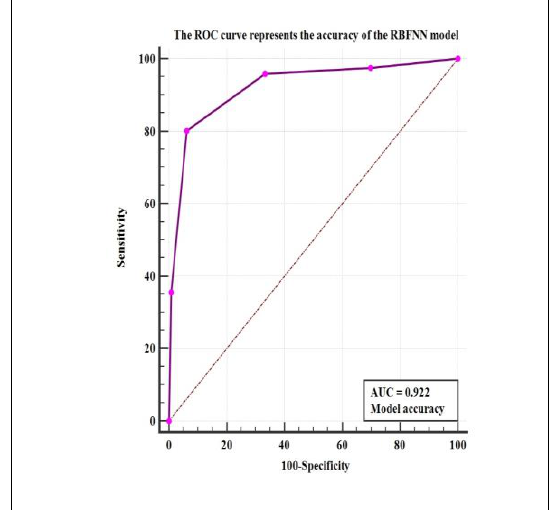
Figure 7. ROC curve for validation the result of the RBFNN